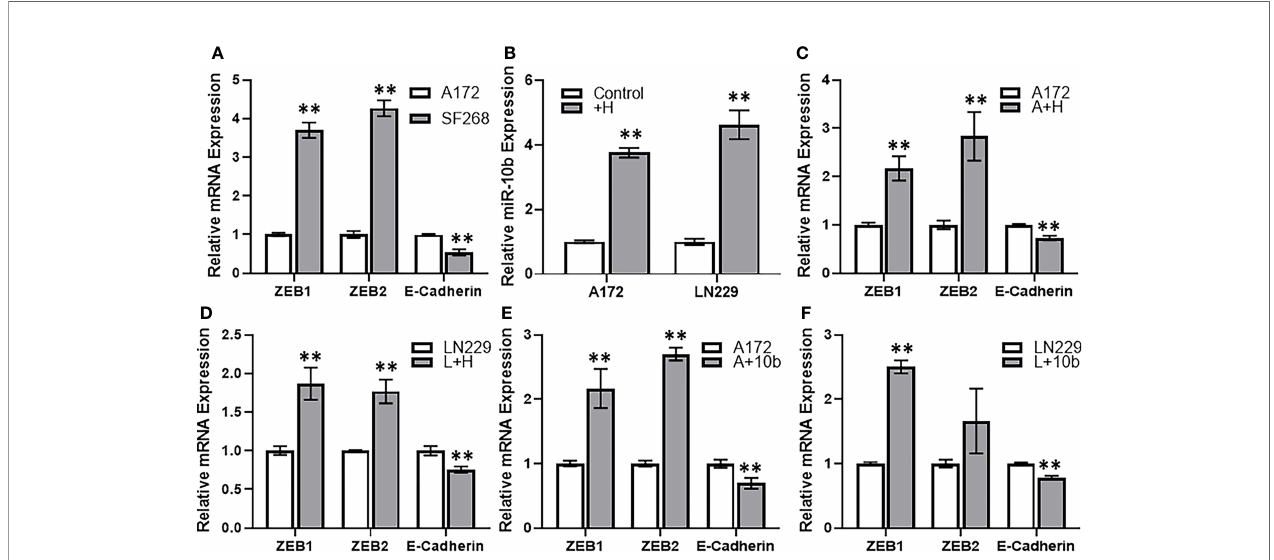
FIGURE 5 | HOTTIP induces miR-10b and EMT in glioma cells. (A) Expression levels of EMT markers were evaluated in A172 vs. SF268 cells, by RT-PCR. The values in A172 cells were regarded as ‘ 1 ’ and relative values in SF268 cells are reported. GAPDH was evaluated as the endogenous control mRNA. (B) A172 and LN229 cells were transfected with lncRNA HOTTIP and expression levels of miR-10b were evaluated in control vs. HOTTIP transfected cells were evaluated by RT- PCR. The levels of miR-10b in control cells were regarded as ‘ 1 ’ and relative levels in HOTTIP transfected cells are reported. RNU6B was used as the endogenous control miRNA. Expression levels of EMT markers were evaluated in A172 cells (C) or LN229 cells (D) transfected with HOTTIP or the A172 cells (E) or LN229 cells (F) transfected with miR-10b (D) by RT-PCR. The values in control cells were regarded as ‘ 1 ’ and relative values in transfected cells are reported. GAPDH was evaluated as the endogenous control mRNA. +H: HOTTIP transfected cells, A+H: A172 cells with HOTTIP, A+10b: A172 cells with miR-10b. **p <